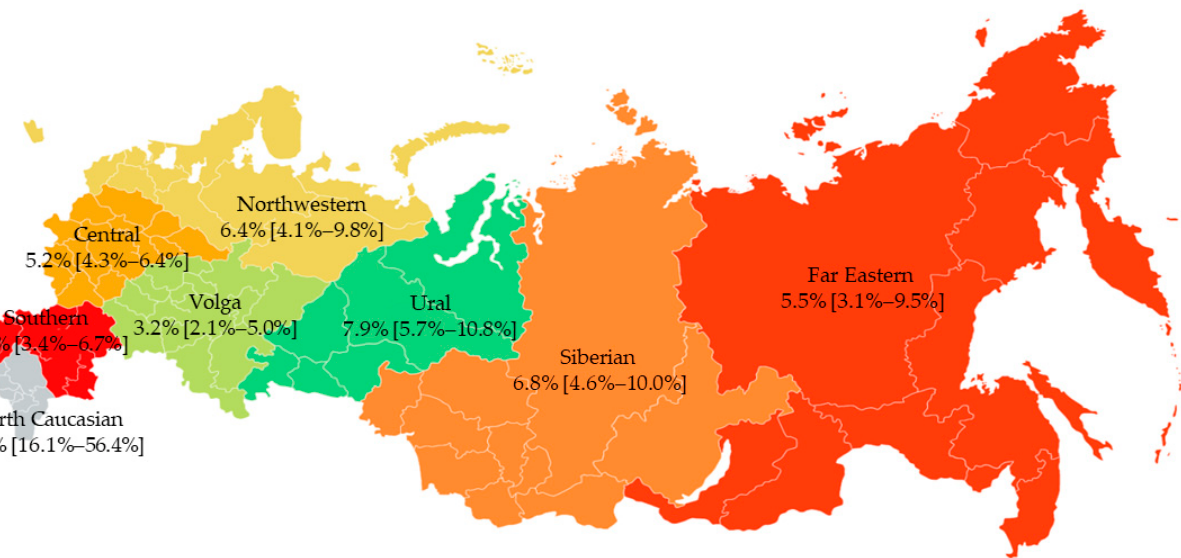
Figure 3. Prevalence of SDRMs in FDs of Russia in the 2006–2022 sampling years. The range of the 95% con fi dence interval is enclosed in square brackets.